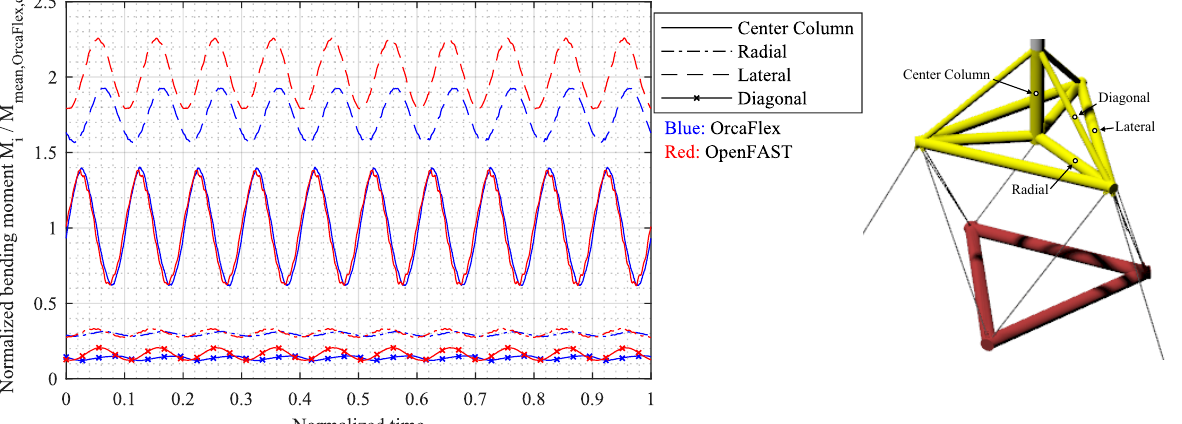
Figure 10. Internal bending moment in the middle of the different components of the structure. The test is for a regular sea state and with a steady wind load. Data are normalized according to the mean bending moment in the center column in OrcaFlex. Only one of each component type is